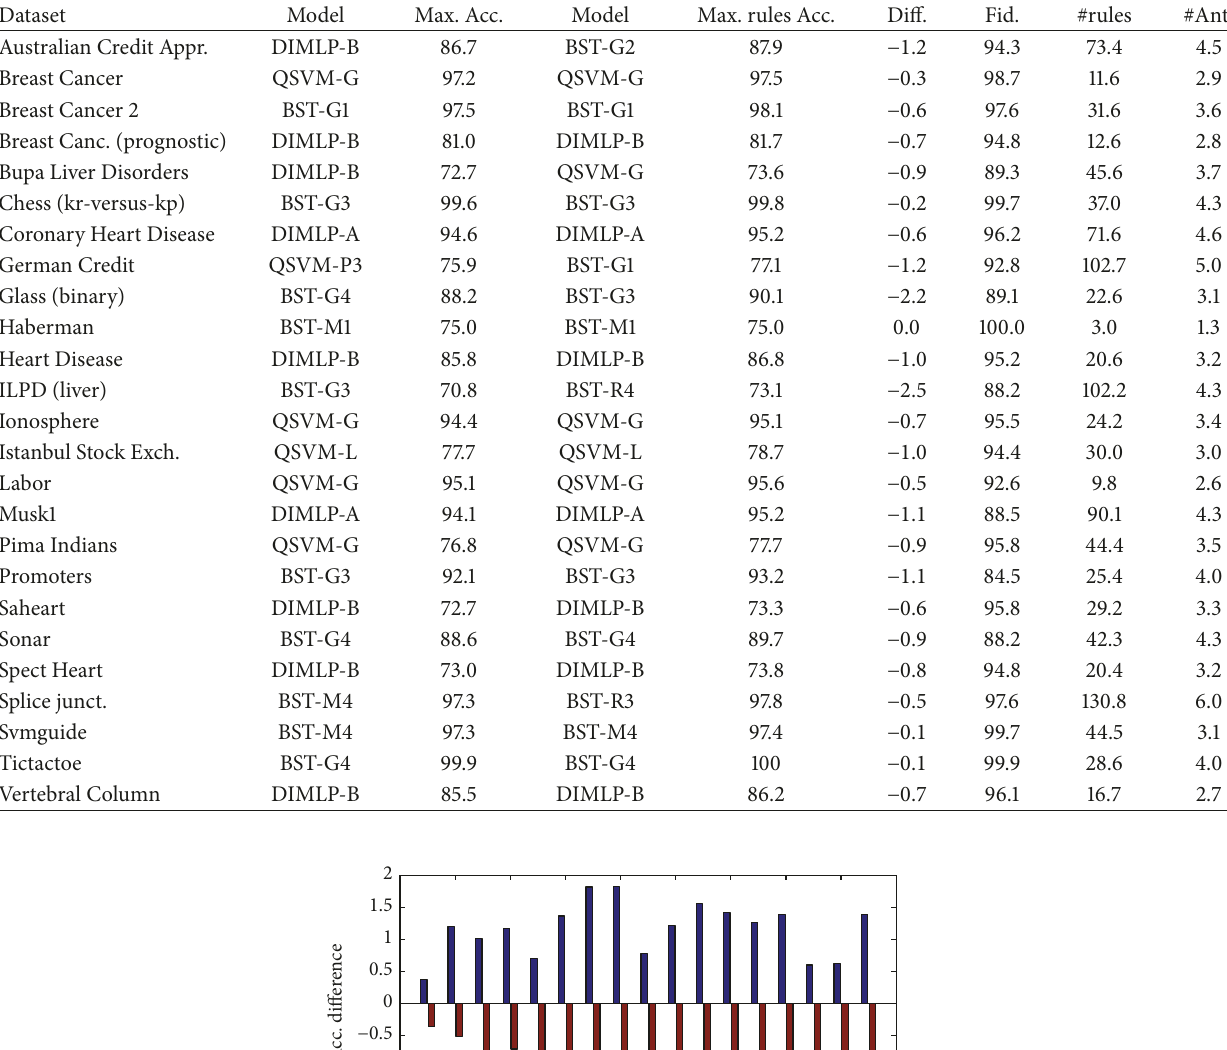
Table 3: Comparison between the average predictive accuracy obtained by the best model (column three) and the average predictive accuracy of the best extracted rulesets (column five) when rules and model agree on classification. The last three columns indicate the average fidelity, the average number of generated rules, and the average number of antecedents per rule, respectively.